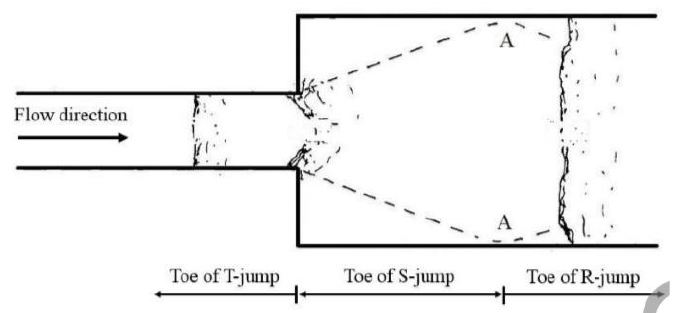
Figure 1. Different kinds of hydraulic jumps in a channel with sudden expansion [6] (Bremen 1990).